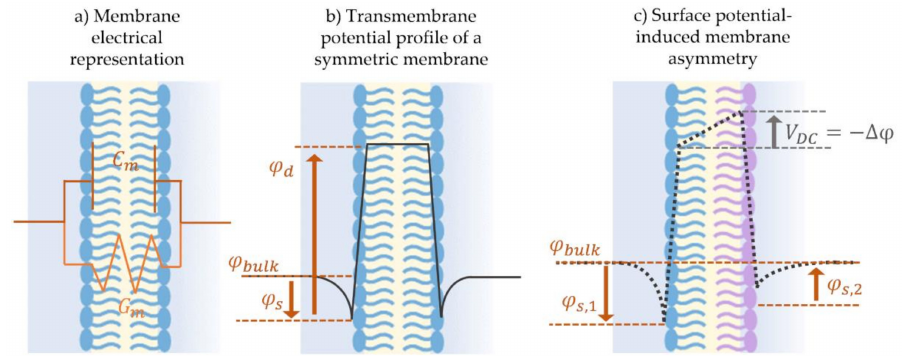
Figure 7. Membrane electrostatics. ( a ) Membranes are electrically modeled as a capacitor and a resistor in parallel. Membrane capacitance arises from the permittivity difference between the inner hydrophobic layer and the two outer hydrophilic surfaces, providing the membrane its ability to retain charge. Membrane resistance arises from its impermeability to dissolved species, except in the presence of conductive channels or pores. ( b ) The monolayer surface potential, ϕ s , and dipole potential, ϕ d , summarize the overall transmembrane potential profile. In the case of a symmetric membrane, lipid leaflets are identically composed and consequently show similar surface and dipole potentials. This leads to a symmetric transmembrane potential profile, as indicated by the solid lines. ( c ) In the case of an asymmetric membrane, the lipid leaflets are formed with different lipid mixtures leading to different surface and/or dipole potentials. This schematic illustrates an example of one leaflet possessing a lower surface potential generating a mismatch across the membrane, characterized by the asymmetric potential in the bulk, ∆ ϕ . When electrodes are placed in the bulk and the membrane is short-circuited in voltage-clamp mode at 0 mV, an electric field is produced across the membrane as the asymmetric values in the bulk are